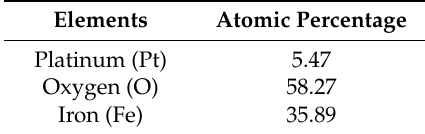
Table 1. EDX analysis for the spherical hematite (Sp-HNP) with Pt coating.